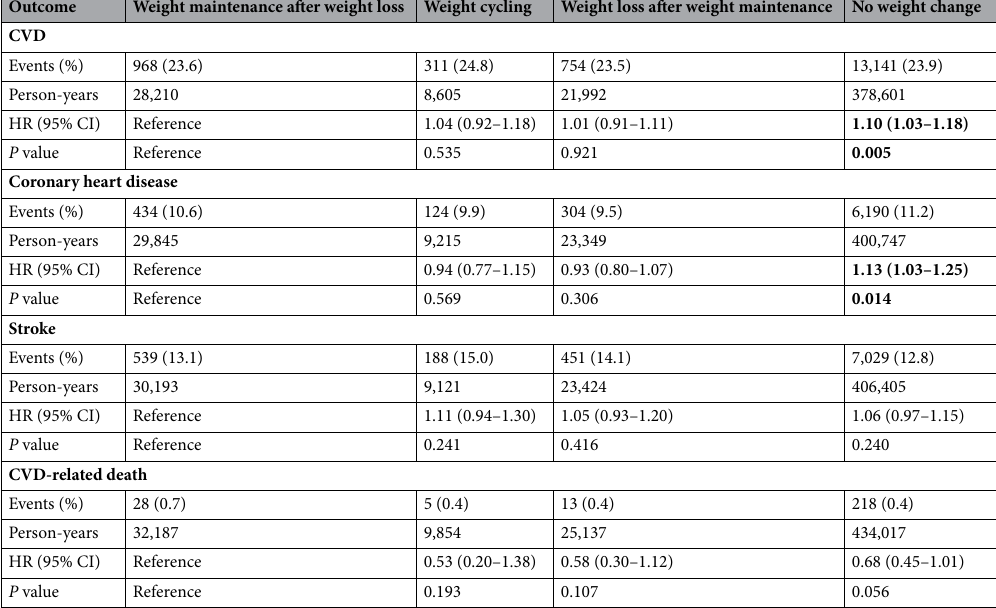
Table 3. Effects of weight loss maintenance on cardiovascular risk compared to those with weight loss-weight gain, weight stable-weight loss, and weight stable-weight maintenance groups. Statistically significant values are given in bold at P < 0.05. HR calculated by Cox proportional hazards regression analysis after adjustments for age, sex, household income, initial body mass index, systolic blood pressure, fasting serum glucose, total cholesterol, aspartate aminotransferase, Charlson comorbidity index, smoking, alcohol consumption, and exercise. Acronyms: CVD, cardiovascular disease; HR, hazard ratio; CI, confidence